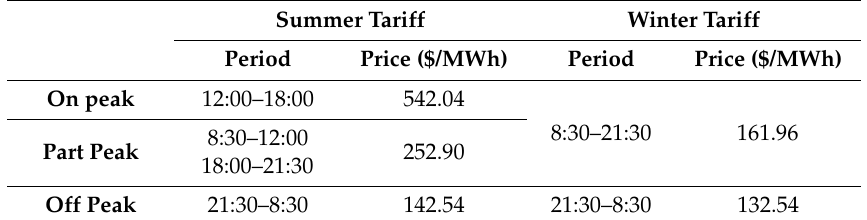
Table 6. Peak Active Power and location of loads. Bus